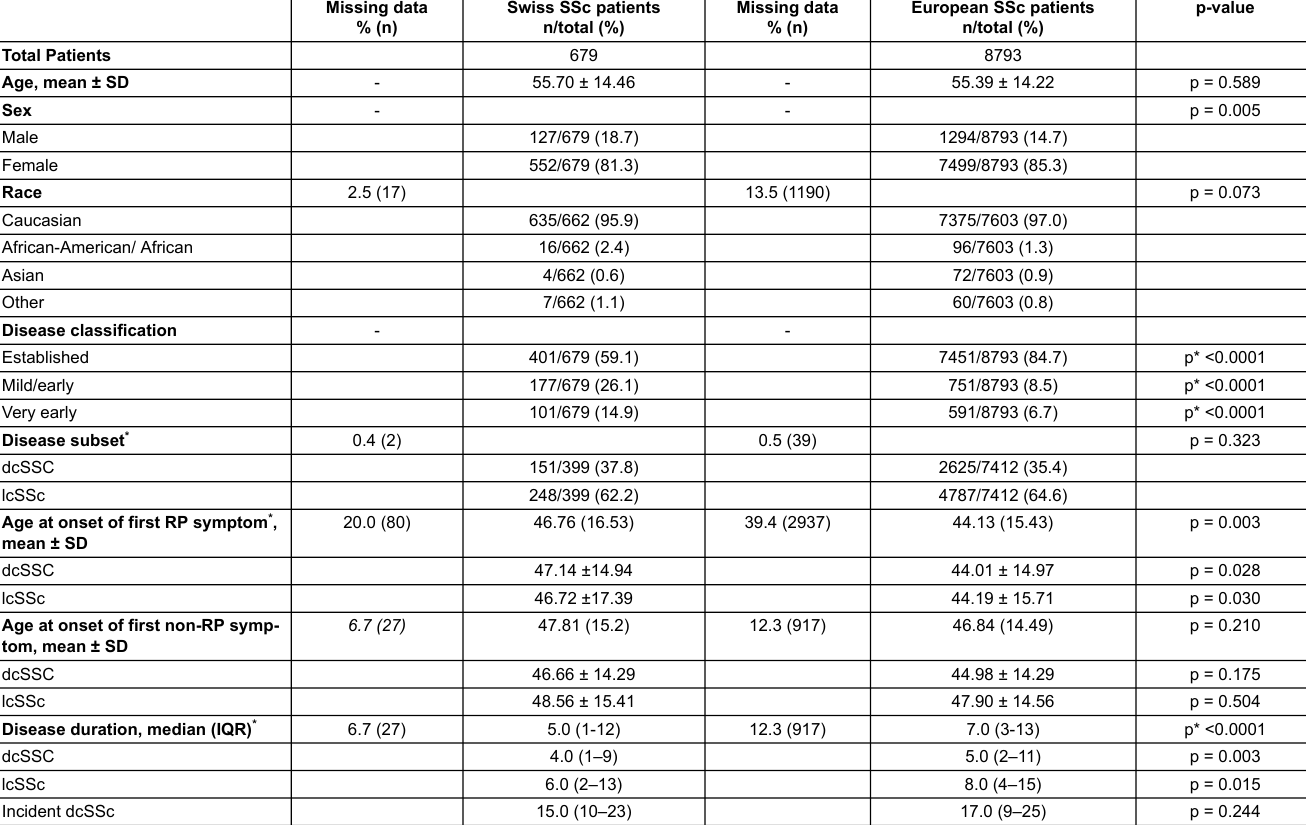
Table 3: Demographic information of Swiss and European patients